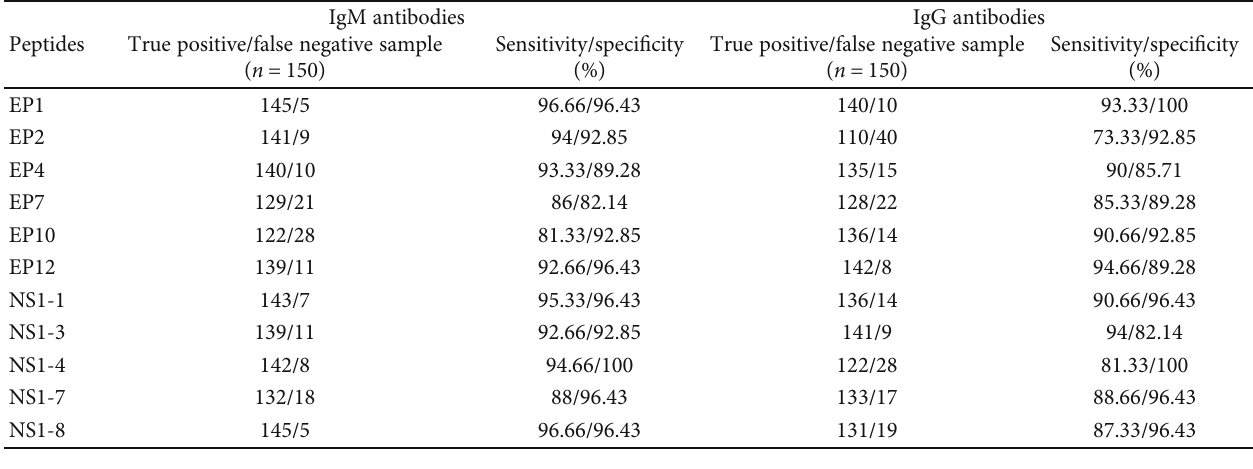
Table 2: Sensitivity and speci fi city of peptides. Peptides showed 73.33 to 96.66% of sensitivity and signi fi cant range of speci fi city with the dengue virus-speci fi c IgM and IgG antibodies.